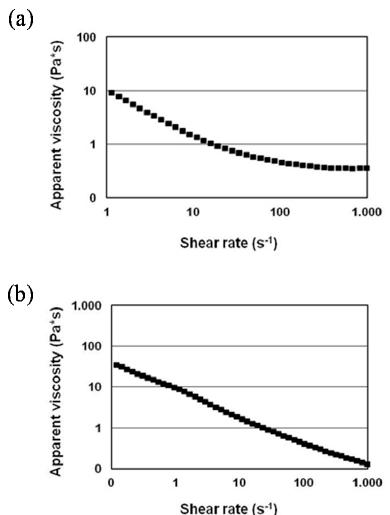
Figure 3. Rheological properties of the inks. Apparent viscosity is expressed as a function of shear rate for ( a ) negative electrode ink and ( b ) positive electrode